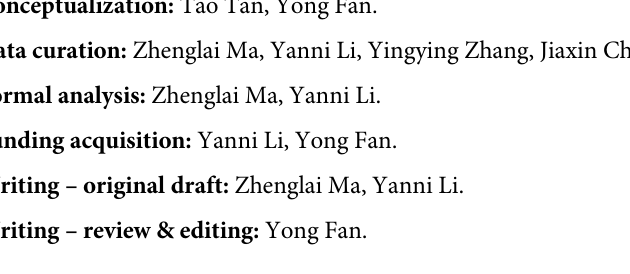
S2 Fig. (A B) DEGs among three groups and volcano plots showed their distributed equally and the number of DEGs from miRNA far more less than that from mRNA. (C) GO and KEGG pathway analysis showed naive and hEPS. (D) DEGs in lncRNA expression among primed, naive hPSC and hEPS. S3 Fig. Venn diagram based on DEGs at mRNA (A), miRNA (B) and lncRNA (C) level. The results shown EPS and naive hPSCs share 1233 DEGs on mRNA level, 16 DEGs on miRNA and 455 DEGs on lncRNA